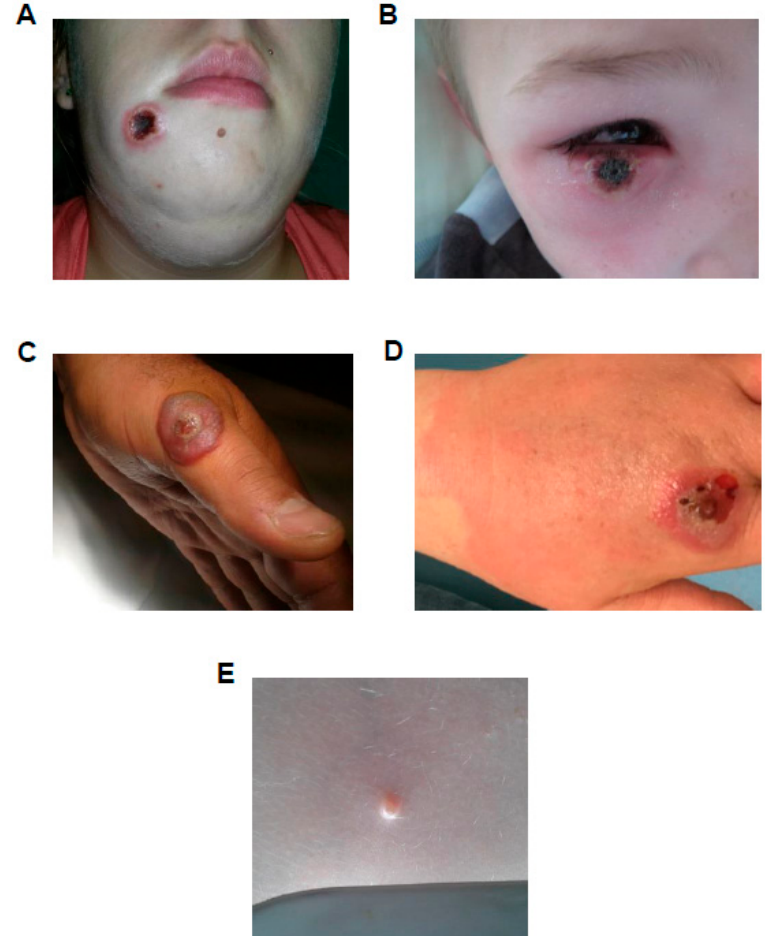
Figure 2. Poxvirus infection cases treated at the NRC-EL-OPX. Patients with lesions due to cowpox virus (CPXV) ( A , B ), orf virus (ORFV) ( C ), pseudocowpox virus (PCPV) ( D ) and molluscum contagiosum virus (MCOV) ( E ) infection. Lesions are located on the face ( A , B ), on the thumb ( C ), on the hand ( D ) and in the back ( E